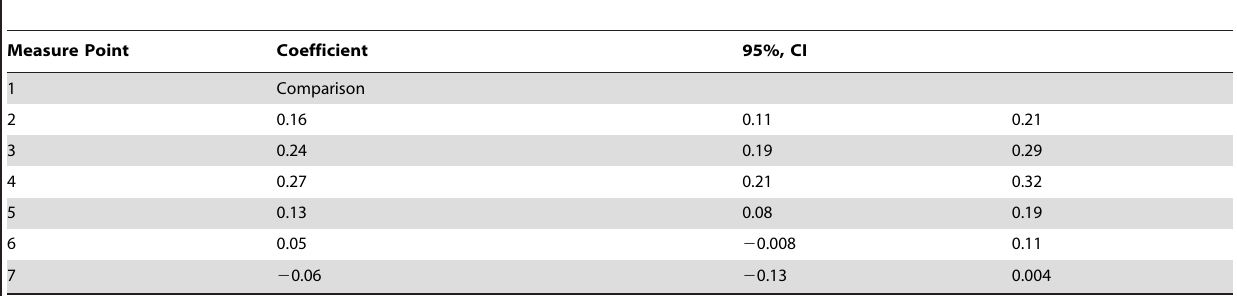
Table 2. Averaged variation of saliva cortisol compared measure point 1 with sex, BMI and age fixed at averaged levels for this